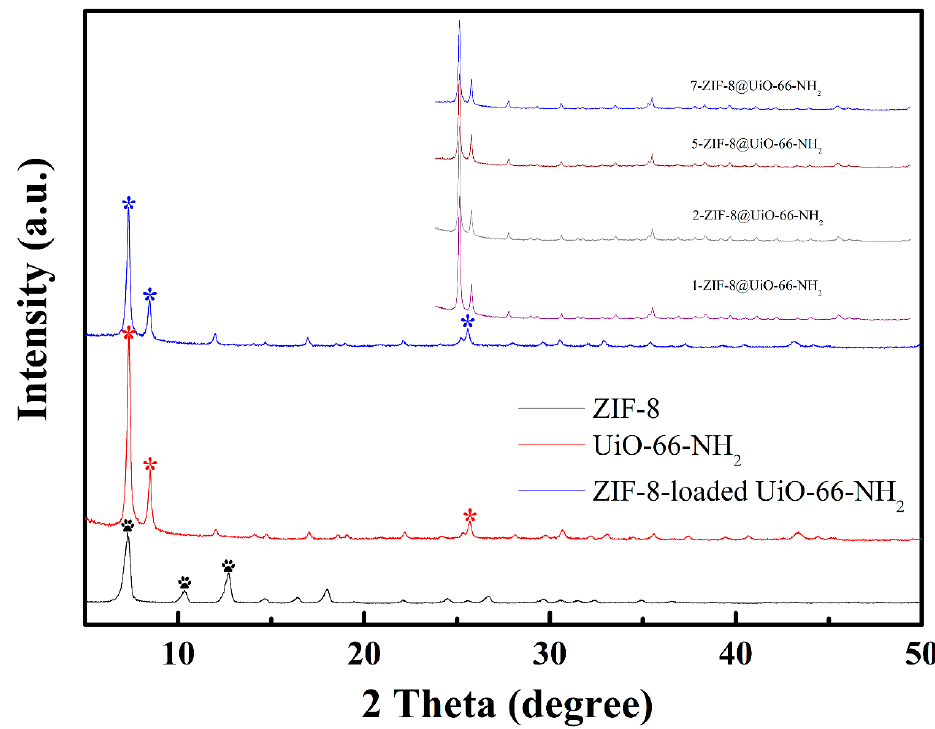
Figure 1. X-ray diffraction (XRD) spectrum of zeolitic imidazolate framework-8 (ZIF-8), UiO-66-NH 2 , ZIF-8-loaded UiO-66-NH 2 . Insets are the XRD spectrum 1-ZIF-8@UiO-66-NH 2 , 2-ZIF-8@UiO-66-NH 2 , 5-ZIF-8@UiO-66-NH 2 , and 7-ZIF-8@UiO-66-NH 2 .